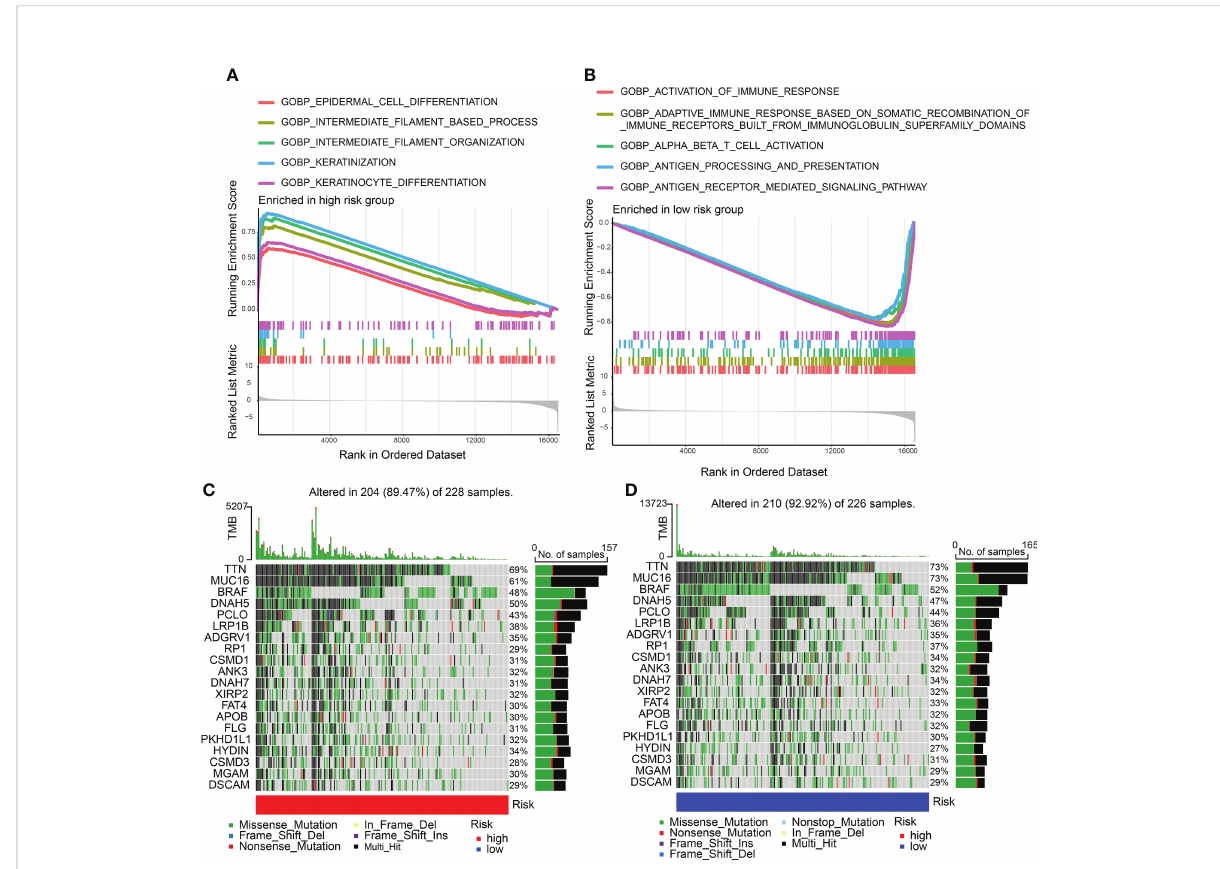
FIGURE 3 GSEA and mutation in high- and low-CDIGPM groups. (A) GO gene sets enriched in high-CDIGPM group. (B) GO gene sets enriched in low- CDIGPM group. (C, D) Signi fi cantly mutated genes in the mutated SKCM samples in high-CDIGPM group (C) and low-CDIGPM group (D) . Mutated genes (rows) are ordered by mutation rate; samples (columns) are arranged to emphasize mutual exclusivity among mutations. The right shows mutation percentage, and the top shows the overall number of mutations. The color-coding indicates the mutation type. CDIGPM: CD8 + T cells-associated immune genes prognostic